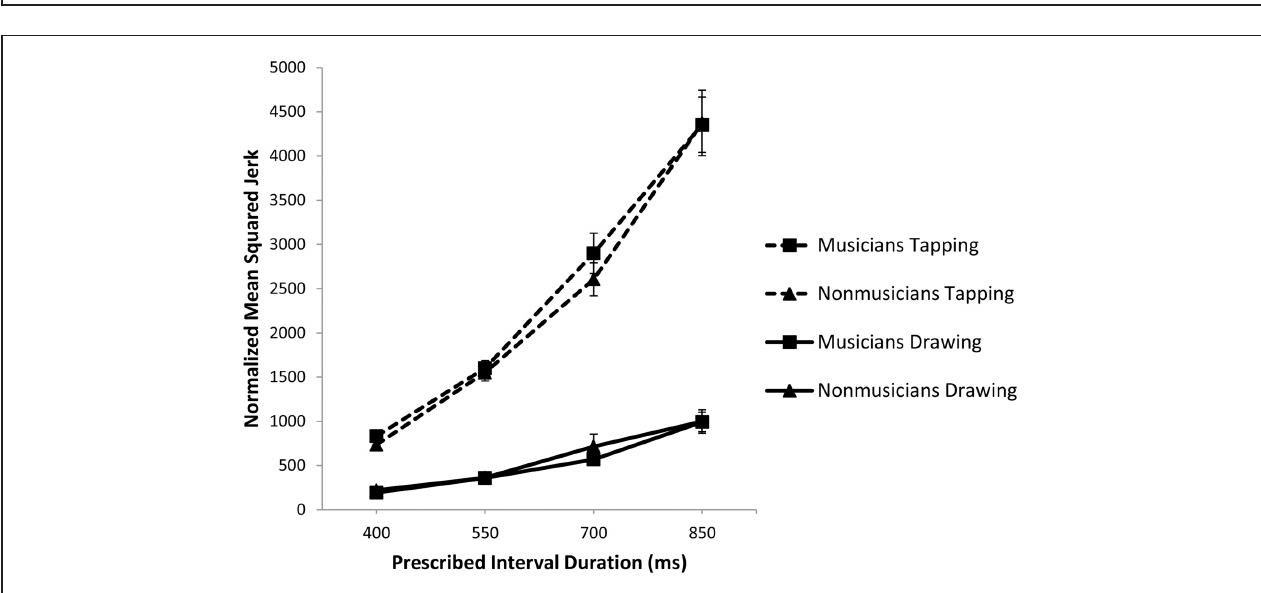
FIGURE 5 | Normalized mean squared jerk plotted against prescribed interval duration and with standard error